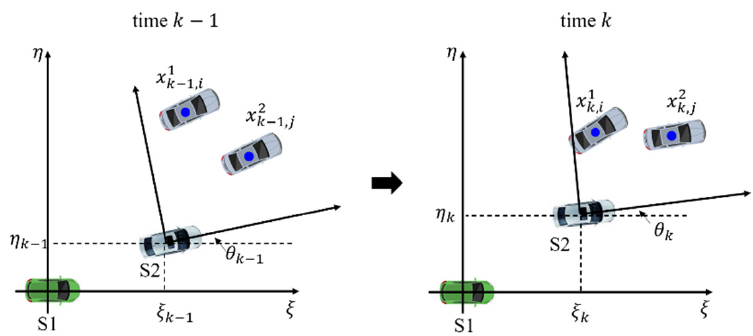
Figure 2. Relative translation and orientation between vehicle S1 and vehicle S2.